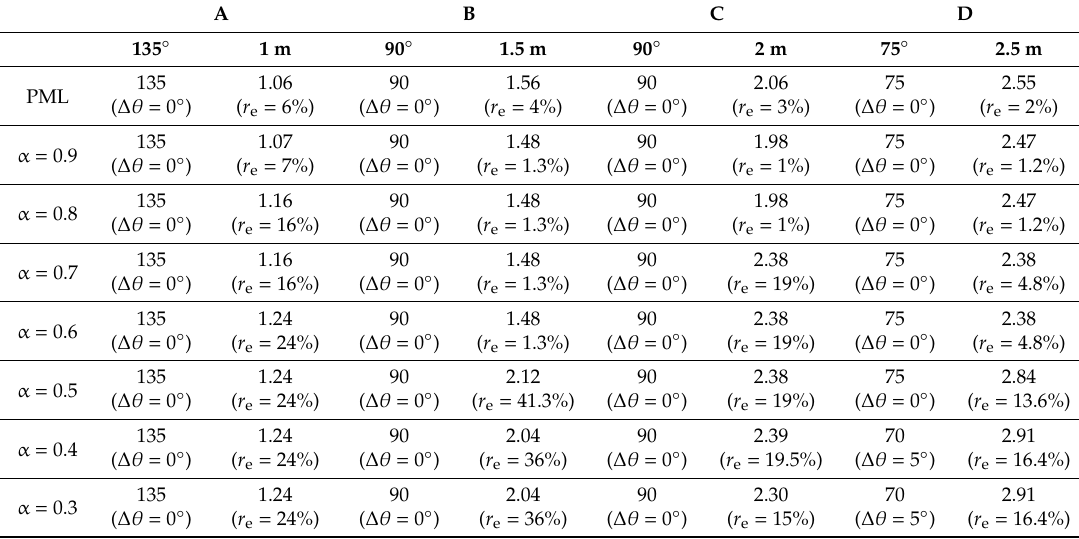
Table 1. Localization performance of the active localization method according to sound absorption at the boundary. The errors in parentheses represent the angular and distance